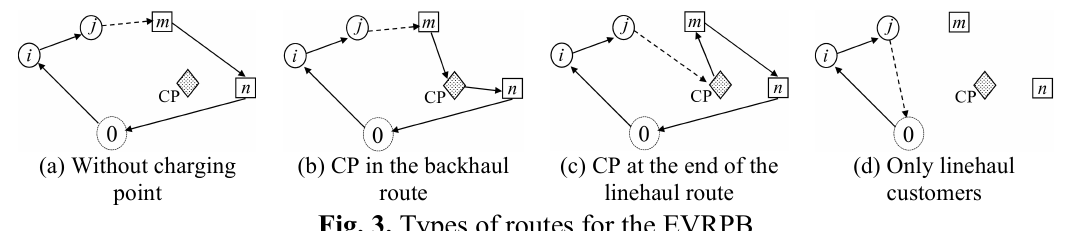
Fig. 3. Types of routes for the